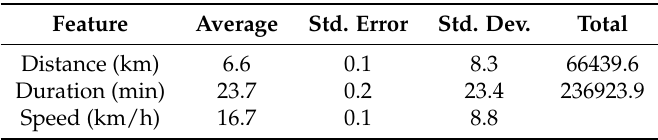
Table 3. A summary of the trip